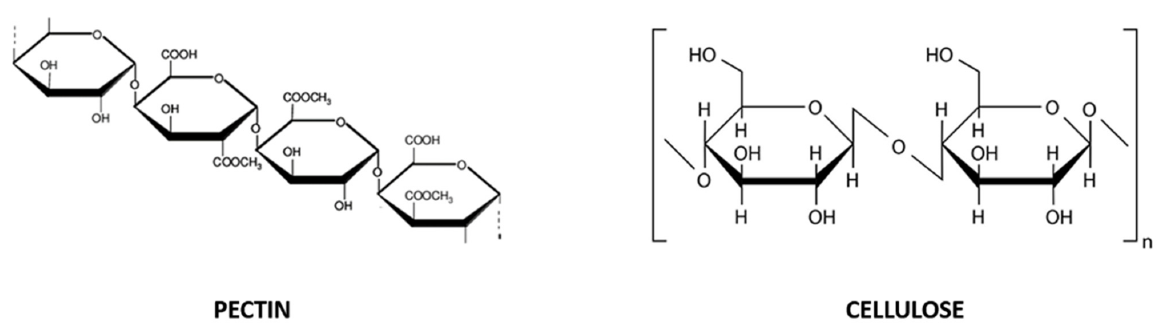
Figure 2. Chemical structure of pectin (D-galacturonic acid units linked together by α -1,4 glycosidic bonds; on the left ) and cellulose (glucose units − 300–3000 molecules- linked by a β -1,4 glycosidic bond; on the right ), soluble and insoluble dietary fibers, respectively.